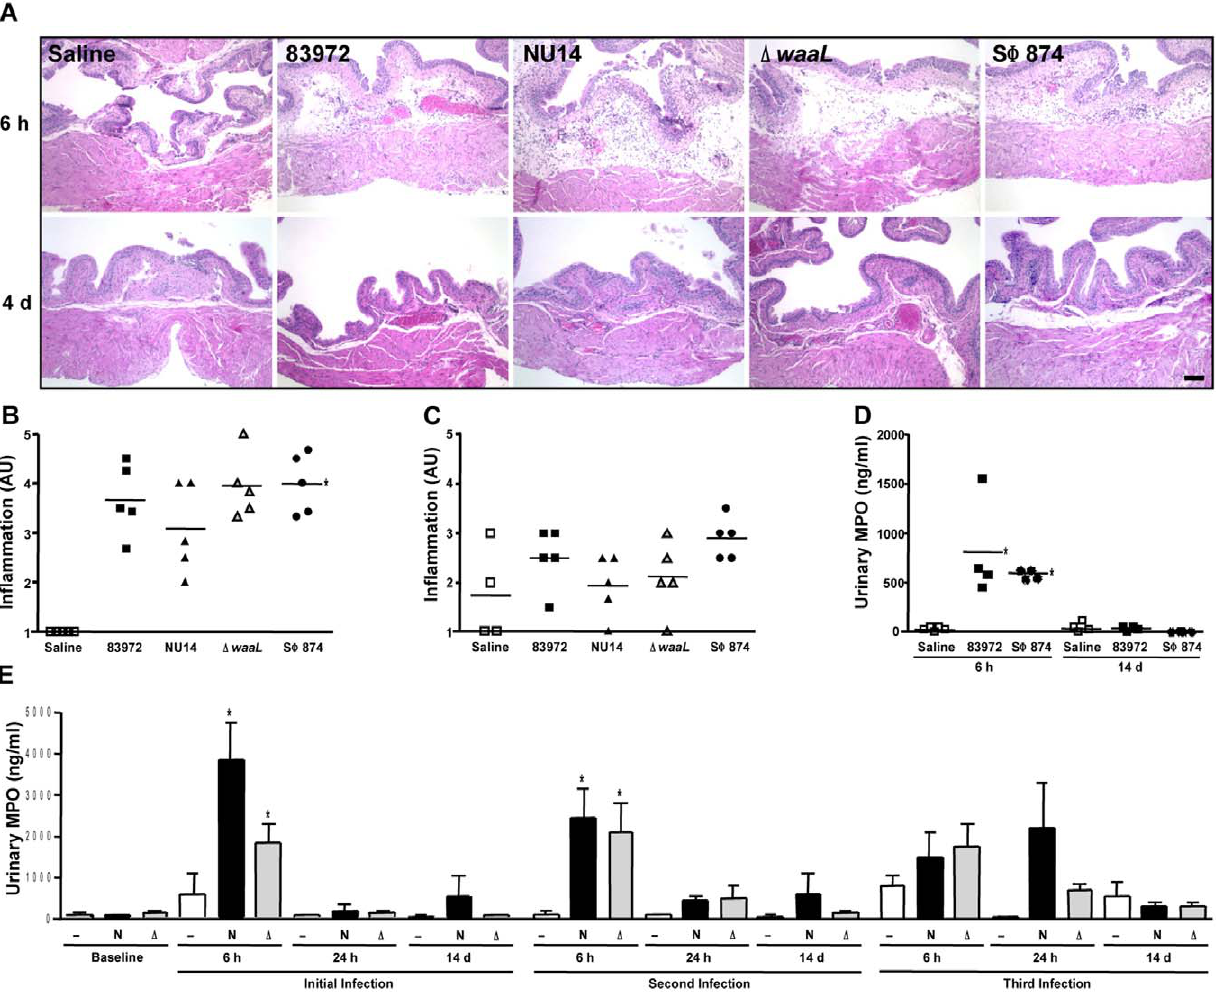
Figure 3. E.coli with differential pain phenotypes do not elicit differential inflammation. ( A ) Hematoxylin-eosin stained sections of bladders from mice instilled with saline, 83972, NU14, D waaL , and S W 874 appeared similar at 6 hours and 14 days. Calibration mark is 100 m m. ( B ) Inflammation that was scored by a blinded reviewer and expressed as arbitrary units (AU) was significantly elevated for 83972-, NU14-, D waaL- , and S W 874-infected bladders harvested at 6 hours, relative to saline (P , 0.001) but was not significantly different among E. coli . ( C ) Inflammation scores were not significantly different for 83972-, NU14-, D waaL- , and S W 874-infected bladders harvested at 14 days (P=0.11). ( D ) Myeloperoxidase (MPO) was quantified in mouse urine by ELISA. Urines were collected at 6 h and 14 d following instillation of saline, 83972, or S W 874. ( E ) MPO was quantified in mouse urines obtained at baseline or at 6 h, 24 h, and 14 d following serial instillation of saline (—, n=4), NU14 (N, n=4), or D waaL ( D , n=7). *P , 0.05. No significant differences were observed in urinary MPO of mice with treated with NU14 or D waaL.